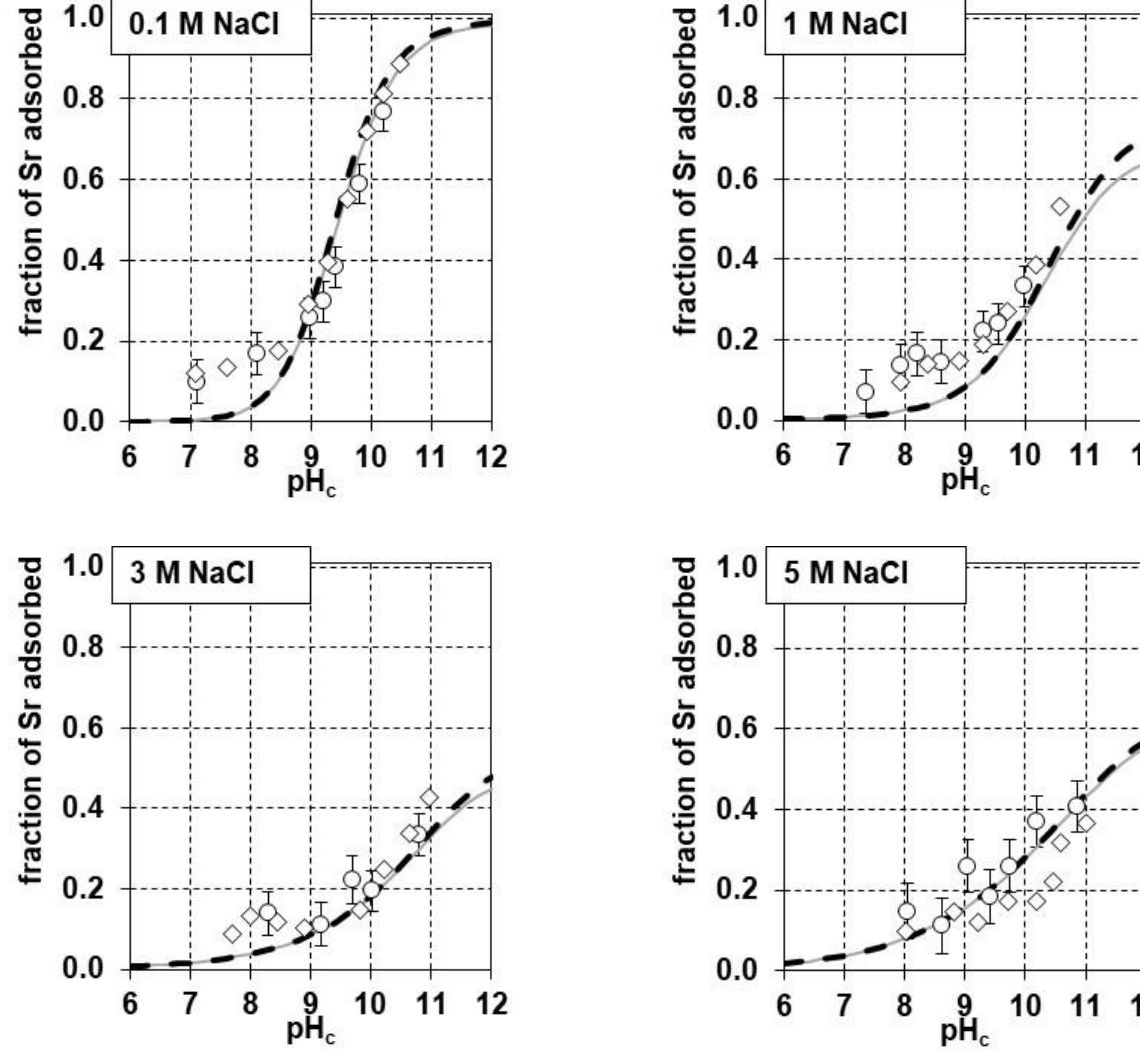
Figure 6. Adsorption edges for Sr (diamonds [Sr] T = 1·10 −5 M; circles [Sr] T = 5·10 −5 M) on iron(III) oxide (7.3 g/L) as a function of pH c and at different NaCl concentrations. Adsorption data (symbols) as percentage uptake. Grey solid lines ([Sr] T = 1·10 −5 M) and black dotted lines ([Sr] T = 5·10 −5 M) are for simulations with parameters from Tables 1 and 2 for (monodentate) adsorption and Pitzer parameters for aqueous species. For the higher strontium concentrations (circles), the error bars are added; for the other dataset, the errors are similar (data not shown).